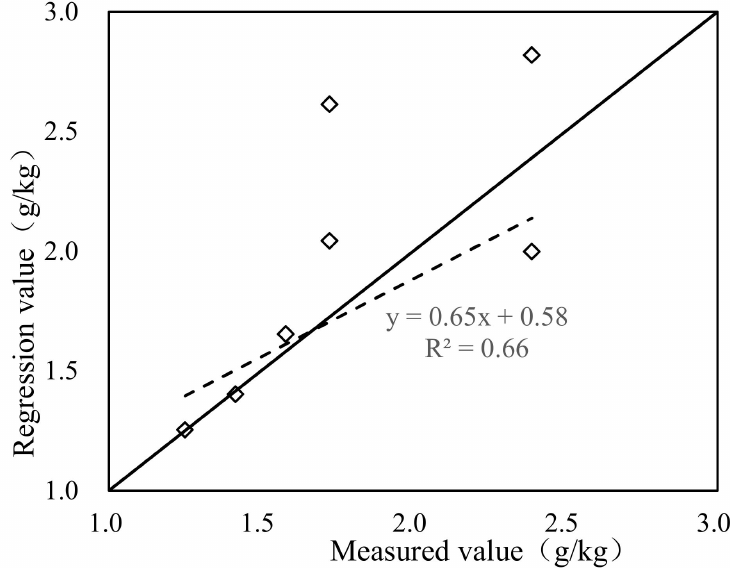
Figure A2. Contrast between measured soil total salinity and that through